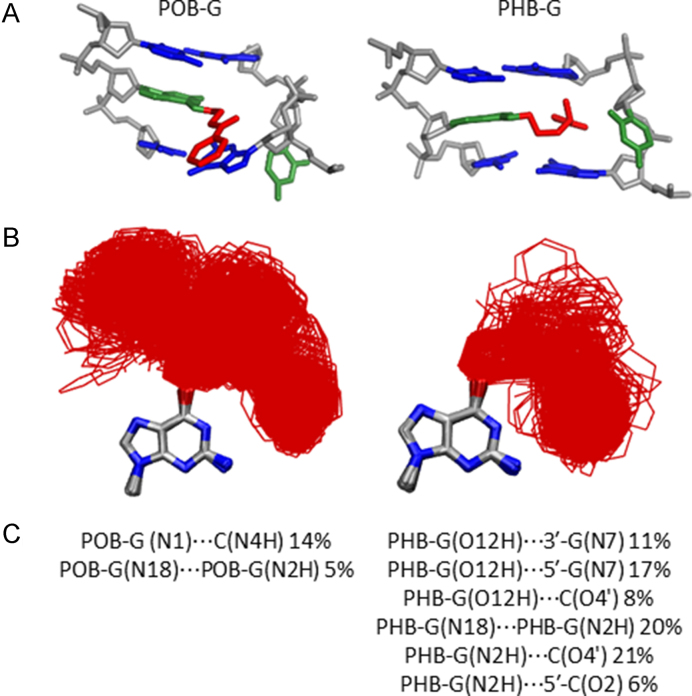
(A) MD representative structures obtained for POB-G (left) and PHB-G (right) adducted DNA based on an initial hydrogen-bonded orientation of the lesion with the pairing C in the major groove. (B) Overlay of lesion conformations adopted throughout the MD simulations, highlighting the deviation in bulky moiety orientation (red). (C) Lesion hydrogen-bonding interactions within DNA.